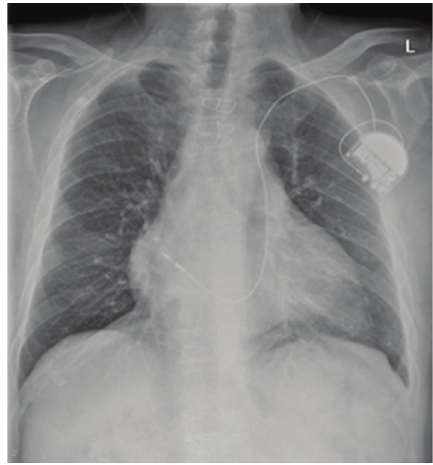
Figure 5: Intravenous lines can appear in unusual locations. This patient had a pacemaker wire placed via the left subclavian vein.